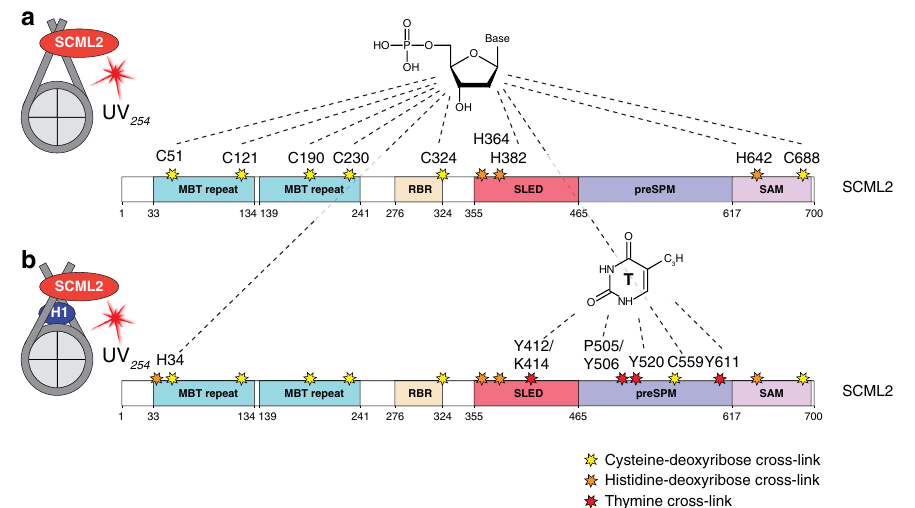
Fig. 3 SCML2 cross-linking to nucleosomes. a Cysteine and histidine cross-links to deoxyribose-phosphates identi fi ed in UV-irradiated samples of the SCML2-nucleosome complex are highlighted with yellow or orange stars, respectively. SCML2 structure is shown schematically and protein domains are indicated. b Cross-links to deoxyribose-phosphate identi fi ed in SCML2-nucleosome + H1 irradiated samples are shown as in a ). Cross-links to thymine are highlighted with red stars and marked by residue number. Non-marked stars represent cross-links to deoxyribose as described under a . Domains: MBT malignant brain tumor, RBR RING-BetweenRING-RING, SLED Scm-Like Embedded Domain, SAM sterile alpha motif,